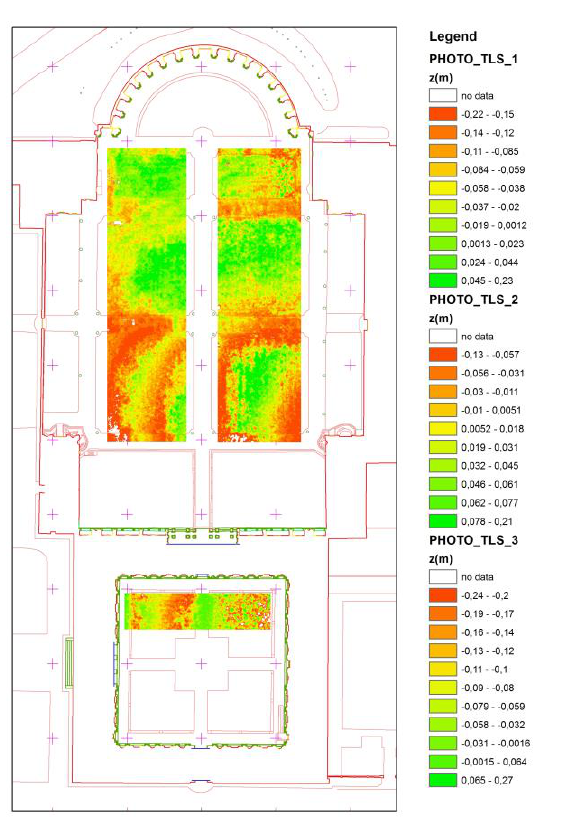
Figure 15. Delta Aerial Photogrammetry -TLS, study areas.